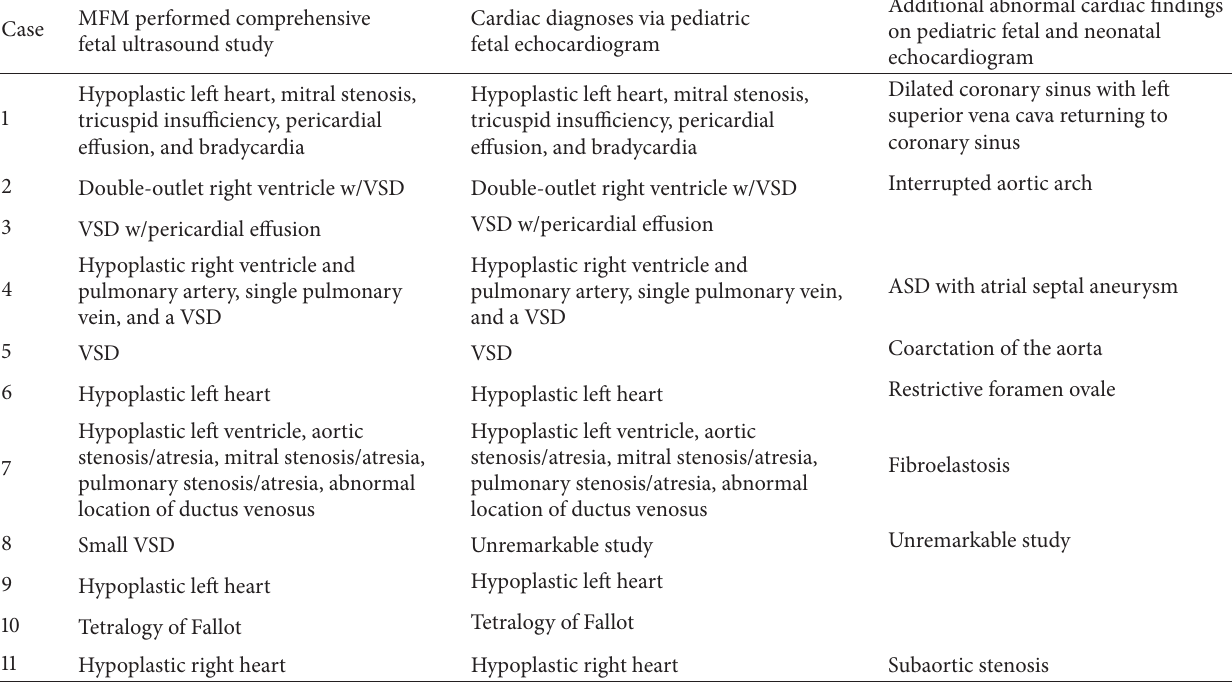
Table 3: Cardiac abnormalities detected by MFM physicians and pediatric cardiologists for fetuses in Group